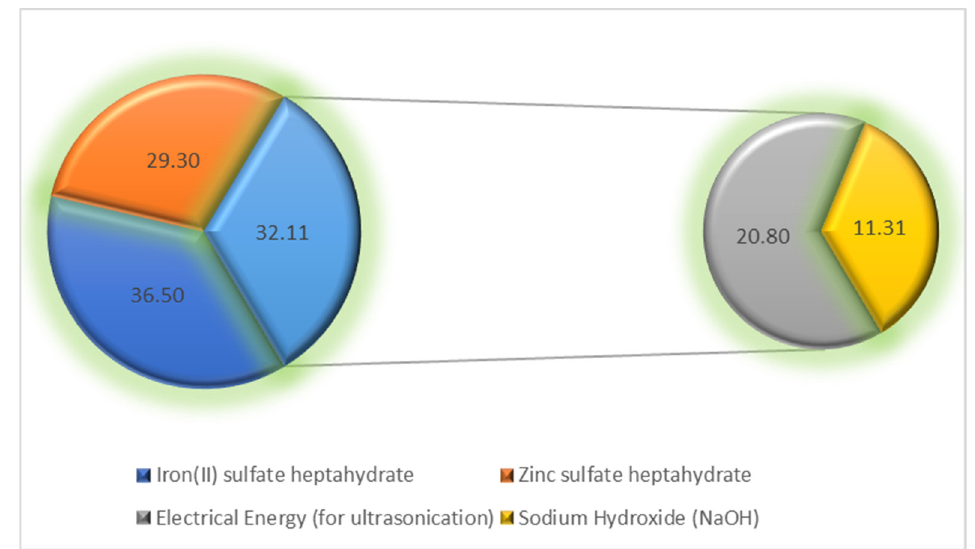
Figure 11. Cost distribution for the removal of CV dye from simulated wastewater at OOP.